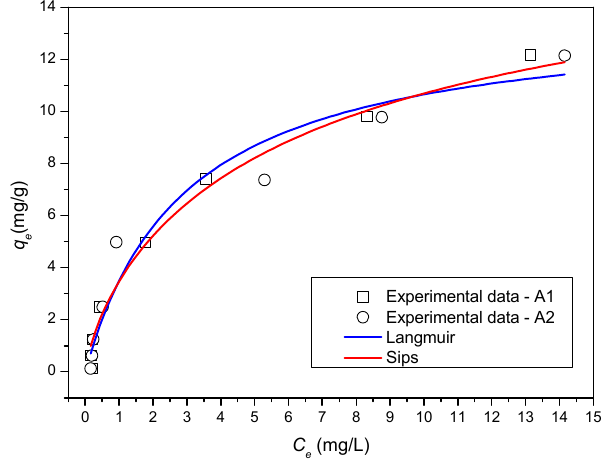
Figure 8. Adsorption isotherm of MB adsorption on AC at 25 °C.